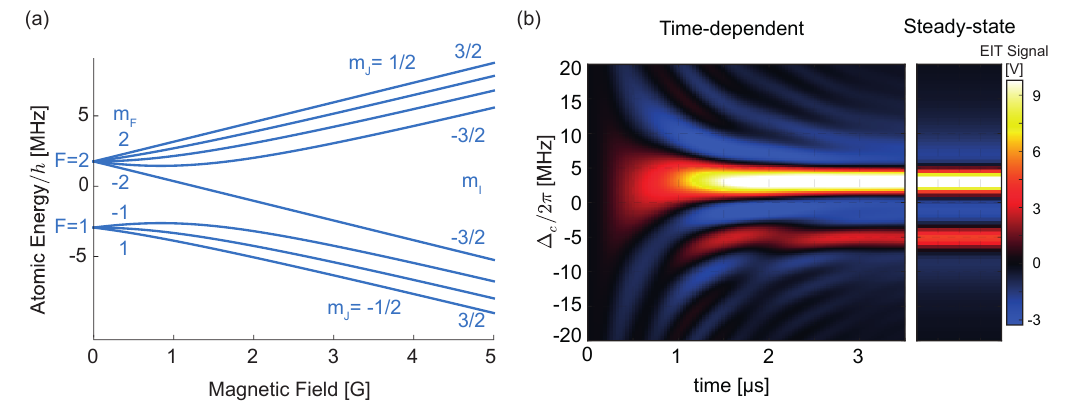
Figure 2: (a) Calculated atomic energies of the magnetic sublevels of 23 s in the Breit-Rabi regime. For small magnetic fields ( (cid:28) 1G) the atomic levels of the hyperfine- states F = 1,2 are labeled by the magnetic quantum numbers m For higher magnetic fields ( > 3G) the nuclear spin I and the electron angular momentum J decouple, and the magnetic levels group according to m compare the time-dependent and the steady-state solutions of the Optical Bloch